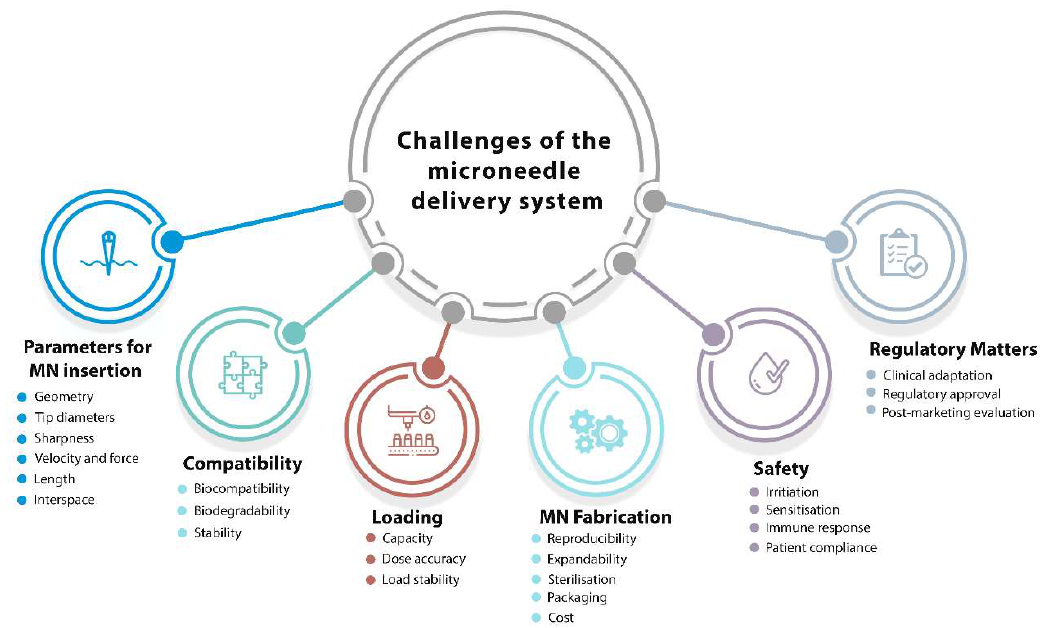
Figure 3. Factors effecting development of microneedle-based delivery